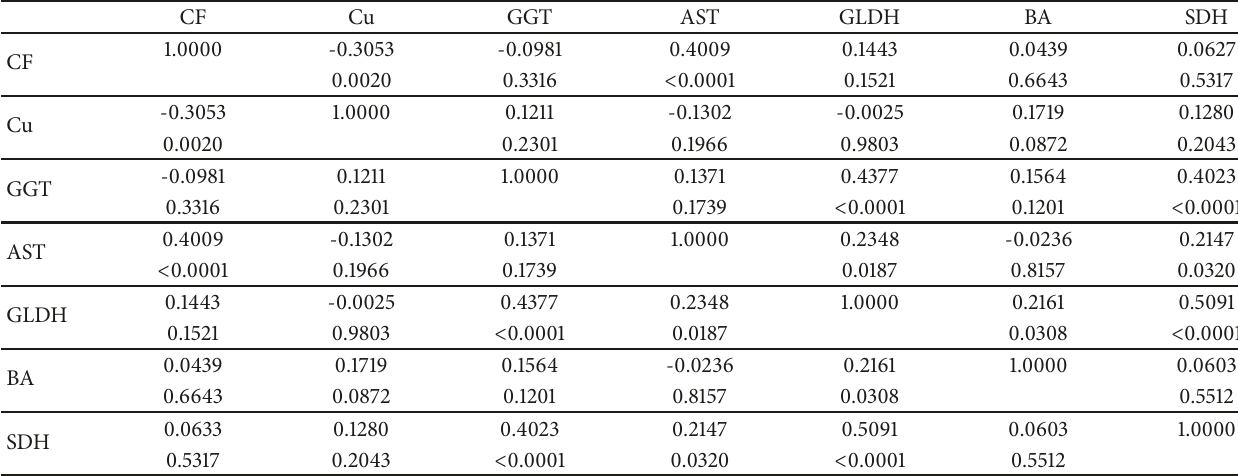
Table 2: Pearson’s correlation.